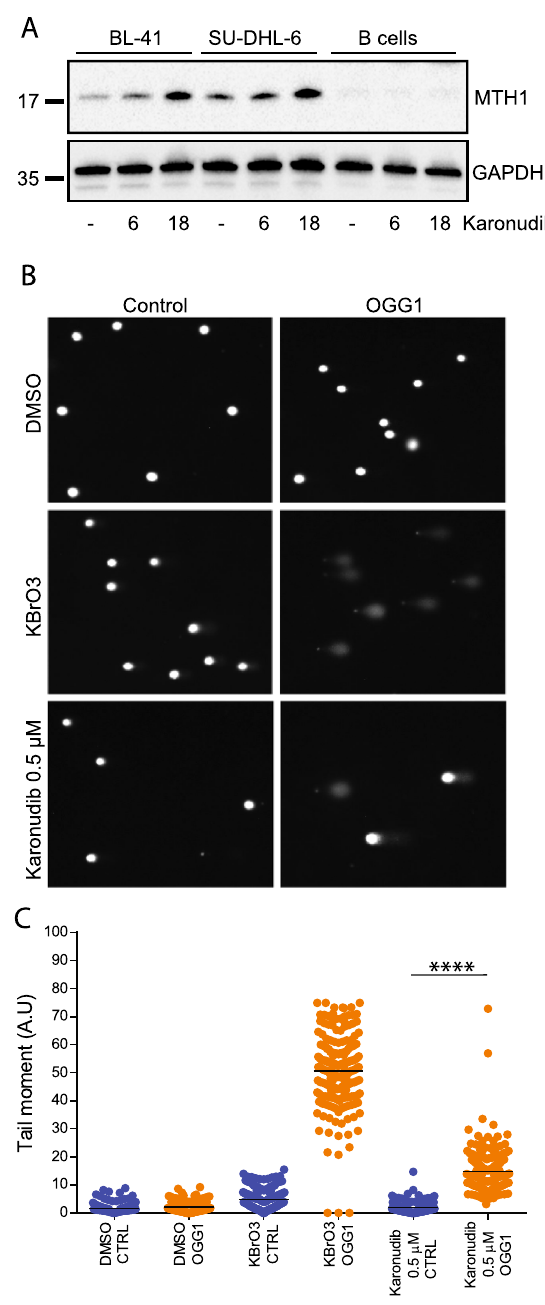
Figure 3. Inhibition of MTH1 leads to increased incorporation of 8-oxo-dGTP. ( A ) MTH1 expression was detected in total cell lysates (karonudib, 0.5 µM, 6 h, 18 h). ( B , C ) A modified comet assay was used to indirectly measure incorporation of 8-oxo-dGTP. An increase in comet tails indicates nick in the DNA by recombinant 8-oxoguanin-DNA-glycosylase (OGG-1) where 8-oxo-dGTP is present. BL-41 cells (karonudib, 0.5 µM, 24 h. KBrO 3 was used as a positive control ( n = 200)). Images are acquired by Zeiss IF microscope and quantified using Comet Assay IV